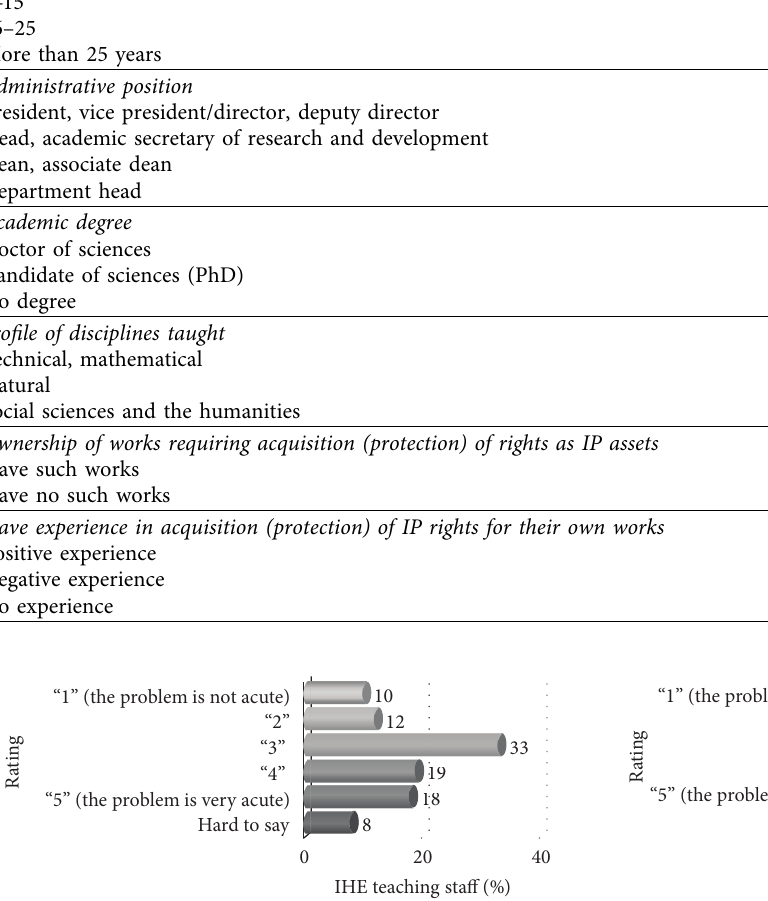
Figure 1: Level of acuteness of IPR infringement problem. Figure 2: Level of IPR infringement influence on day-to-day